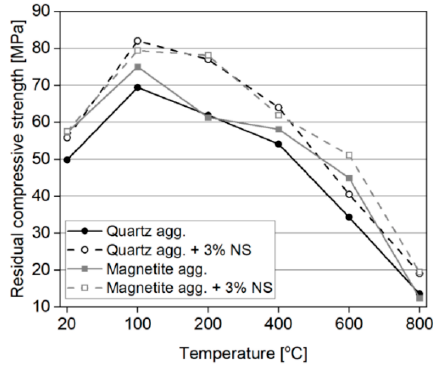
Figure 5. Comparison of residual compressive strengths of cement mortars containing quartz and magnetite aggregate, with and without NS. Reproduced with permission from [28]. Copyright Elsevier, 2017.